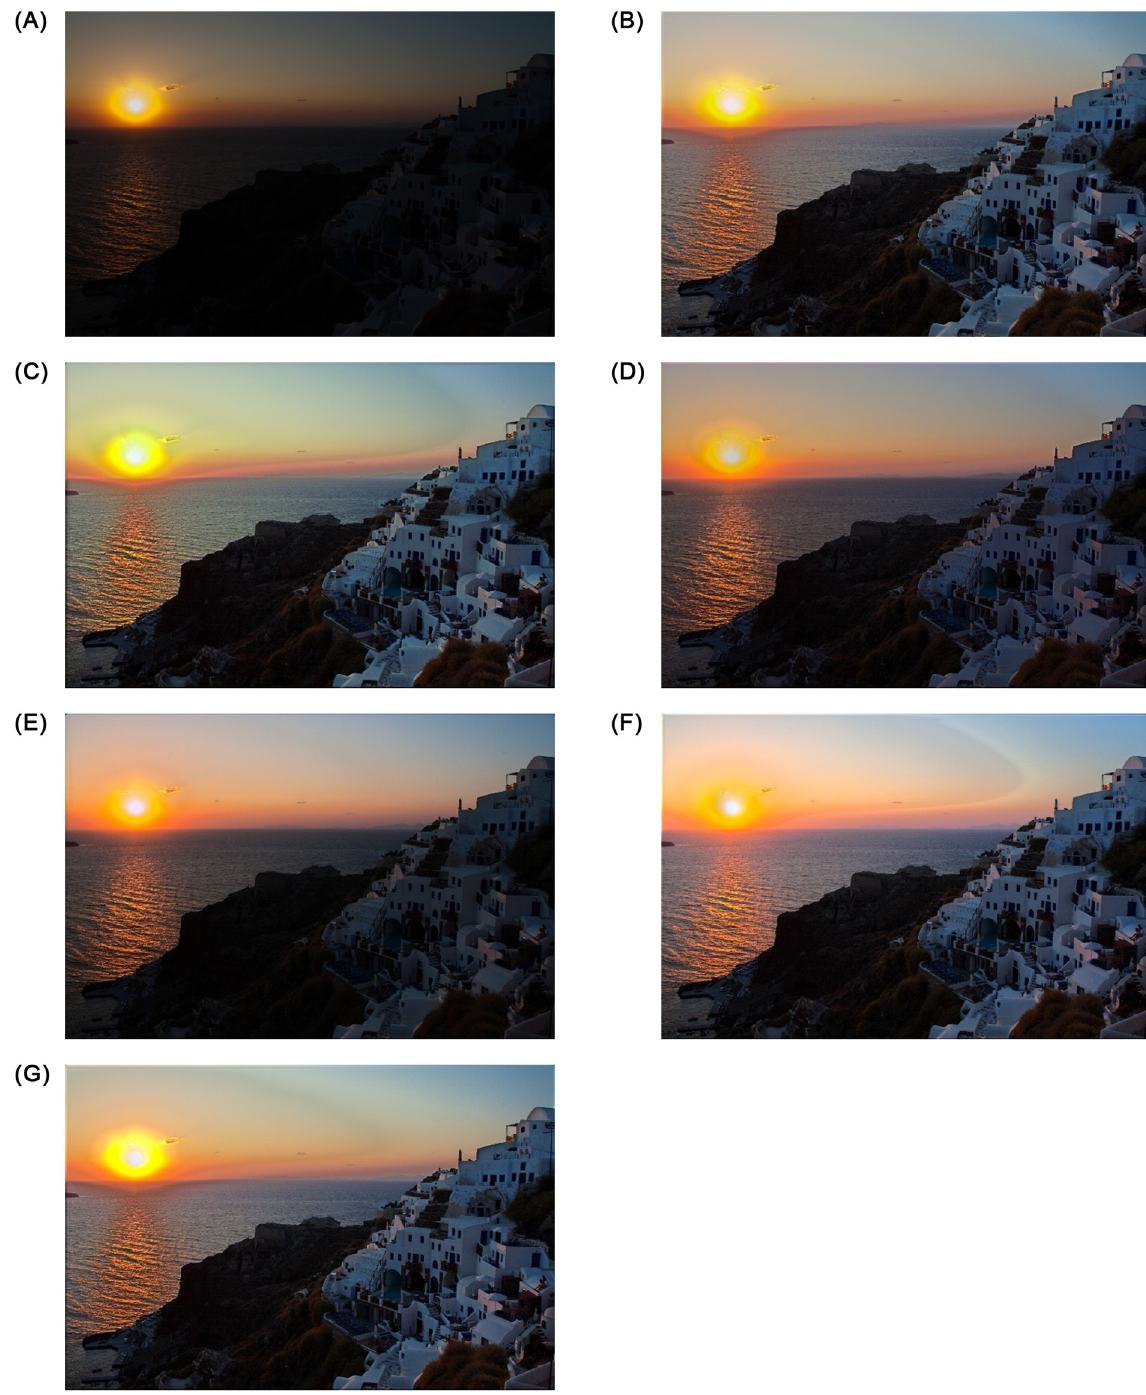
Fig 4. The above figure shows the effect of the loss function parameters. λ s are weights for L 1 , L L brightness . Without the balanced parameters, the network produces deviated outputs. (a) Input Low-light image, (b) Proposed, (c) λ 1 = 0.05, (d) γ 1 = 0.2, (e) γ 2 = 2, (f) λ 2 = 1, and (g) λ 3 = 0.85.